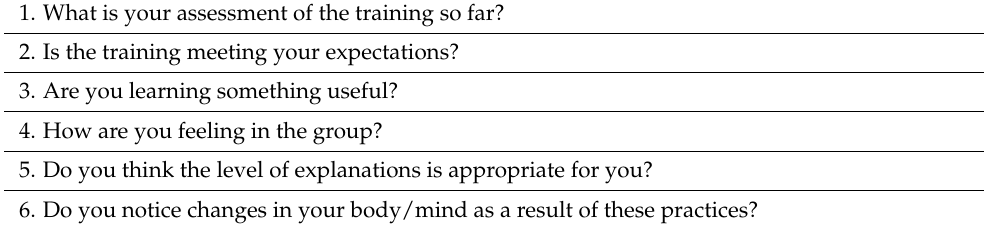
Table A2. Questions from the feedback questionnaire of the intervention process.